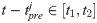
The voltage in the time scope t-tprej∈[t1,t2].The voltage ϵj(sj) caused by the input spike tprej is above ϑv when t-tprej∈[t1,t2]. The voltage of the input tprej is set to 0 at time t if this t-tprej is not in the interval [t1, t2].